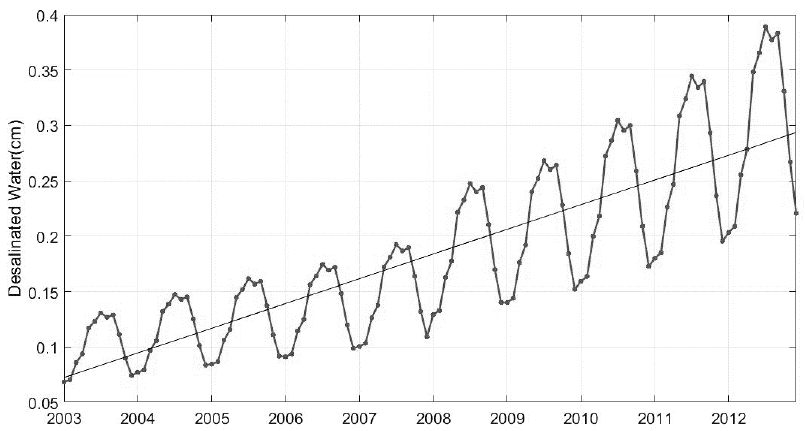
Figure 13. Time series of desalinated water produced from 2003 to 2012.